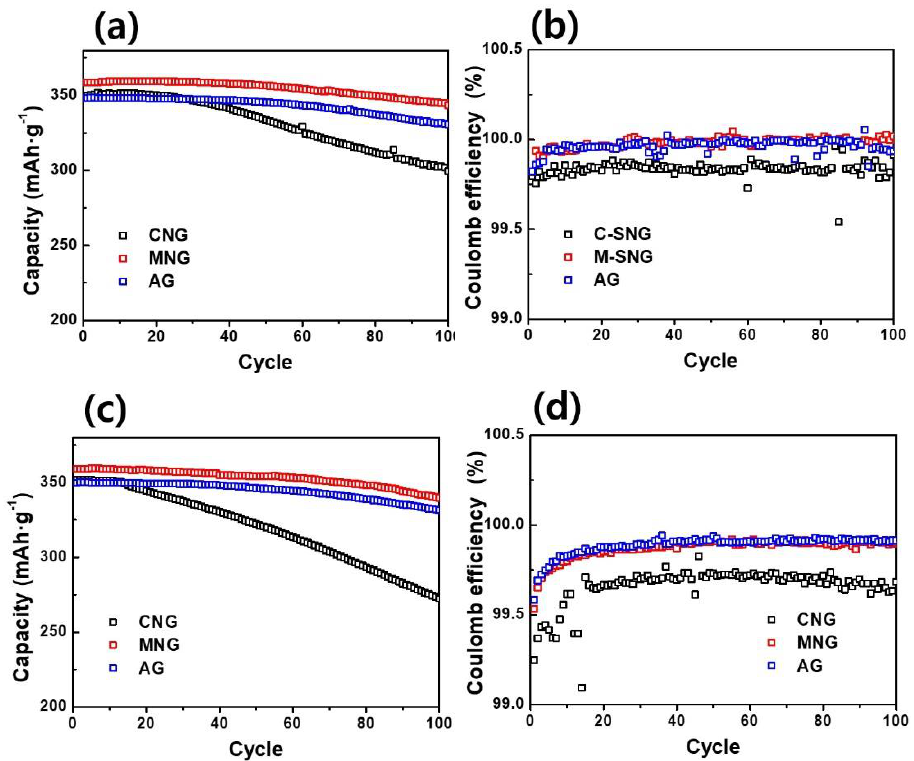
Figure 6. Comparison of cycling performance behavior of CNG and MNG with 1.6 g∙cm −3 electrode density and artificial graphite (AG) with 1.55 g∙cm −3 electrode density at ( a , b ) 30 °C and ( c , d ) 45 °C.